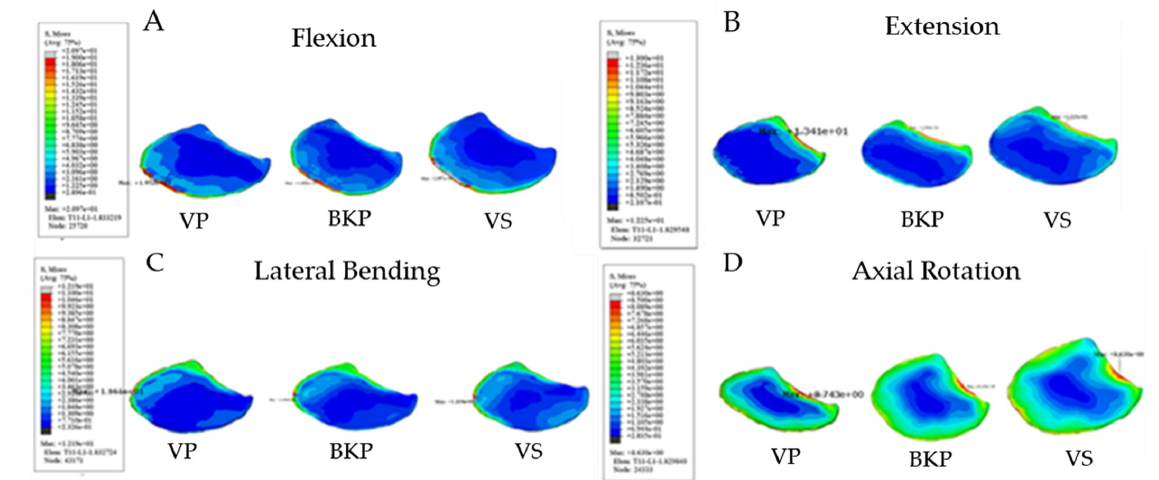
Figure 5. Finite element stress nephogram of interfacial stress at lower T11 endplate. ( A ): Flexion. ( B ): Extension. ( C ): Lateral bending. ( D ): Axial rotation.